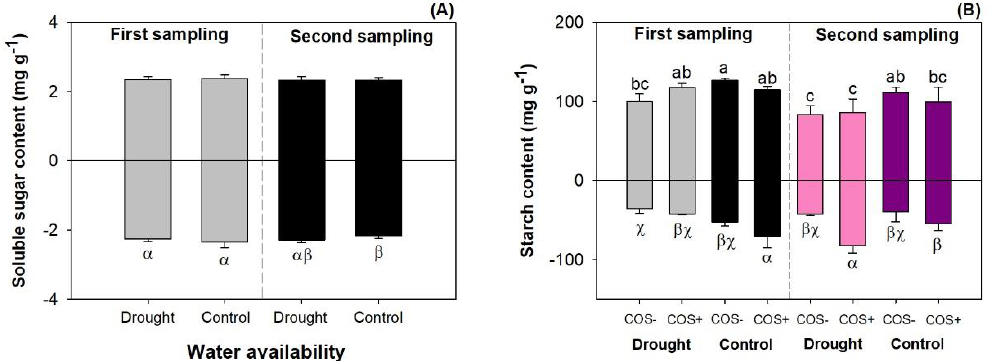
Figure 4. Soluble sugar ( A ) and starch ( B ) contents in two harvests of Buddhist pine ( Podocarpus macrophyllus ) seedlings exposed to contrasting water availabilities (drought vs. irrigated control) and their interaction with chitosan oligosaccharide (COS) addition (COS- vs. COS+). Different letters indicate a significant di ff erence according to Tukey’s test at the 0.05 level. Lower-case letters represent shoot biomass; Greek letters represent root biomass. Error bars stand for standard errors.